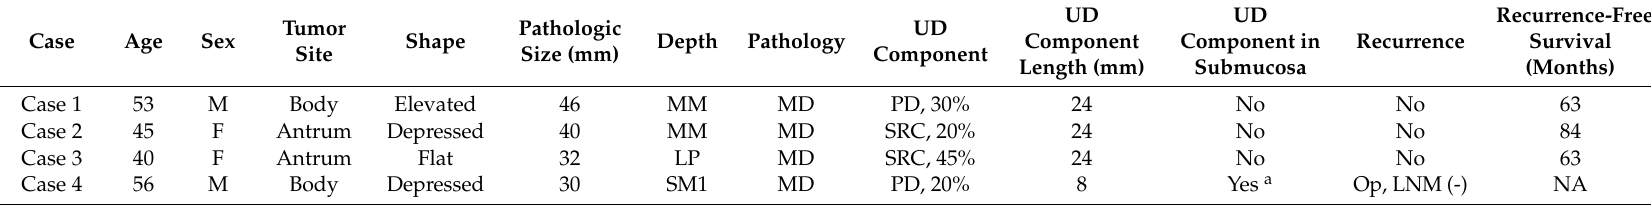
Table 3. Cases of di ff erentiated-type-predominant early gastric cancer with histological heterogeneity with areas of undi ff erentiated component that exceed 20 mm in length or with undi ff erentiated component present in the submucosal invasion